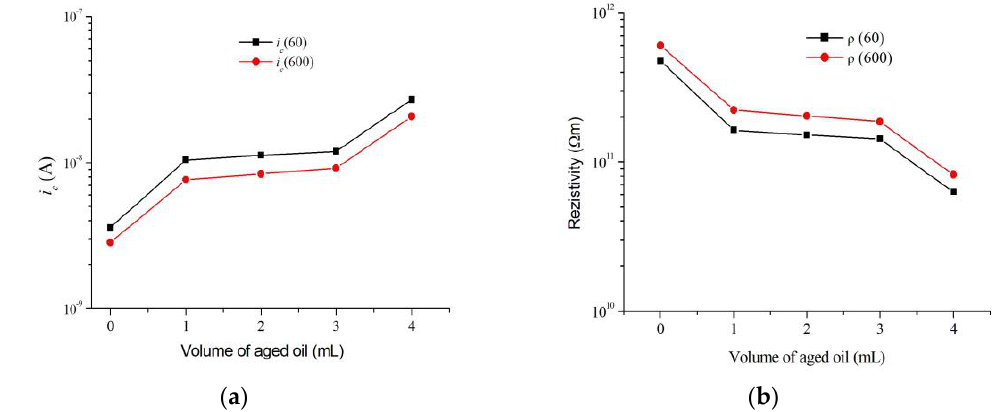
Figure 9. ( a ) The variation of i c (60) and i c (600) as a function of aged oil volume; ( b ) variation of ρ (60) and ρ (600) as a function of aged oil volume. and ρ (600) as a function of aged oil